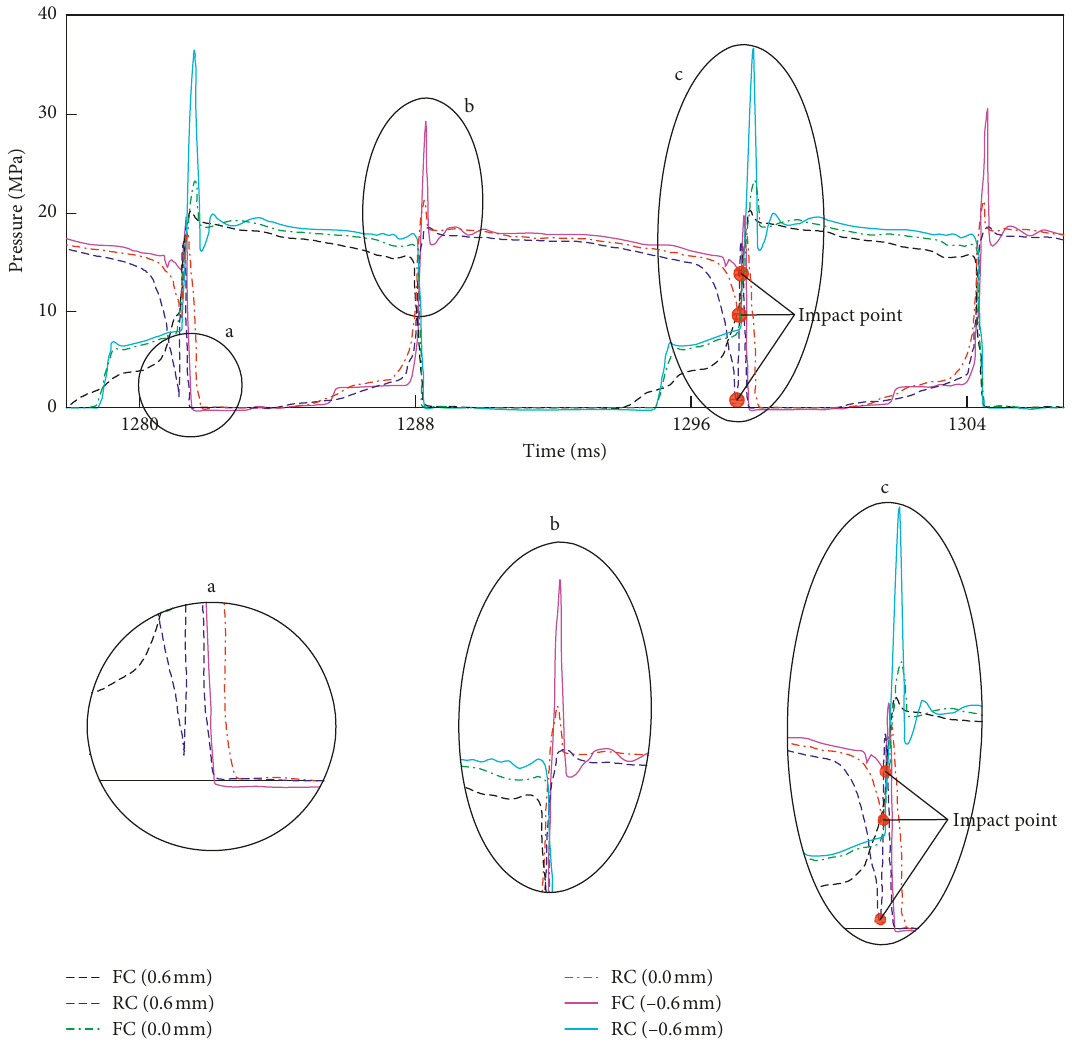
Figure 6: Comparison of front chamber (FC) and rear chamber (RC) pressures among underlapped, zero, and overlapped reversing valves. Note . a: the amplification of negative pressure; b: the amplification of the peak; c: the amplification of the impact